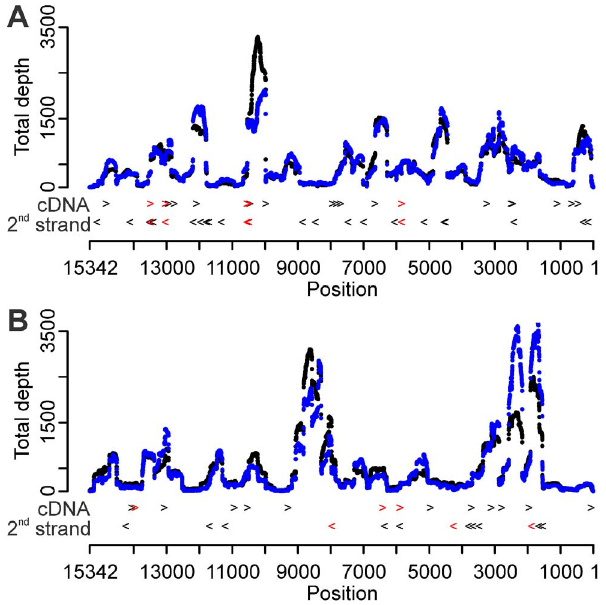
Figure 1. Distribution of sequence depth and enhanced annealing sites for two alternative 6N SISPA primers. (A) FR20RV-6N primer condition, repeat 1 (black) & 2 (blue). (B) K-6N primer condition, repeat 1 (black) & 2 (blue). The X-axis represents the position on the APMV-8 genome. Arrows to the right ( . ) represent potential enhanced annealing sites in the first strand cDNA synthesis direction, arrows to the left ( , ) in the second strand cDNA synthesis reaction. Black arrows symbolize enhanced annealing sites on the genome with five consecutive nucleotides in common with the 3 9 end of the tag of the given SISPA primer; red arrows represent six or more common consecutive nucleotides.